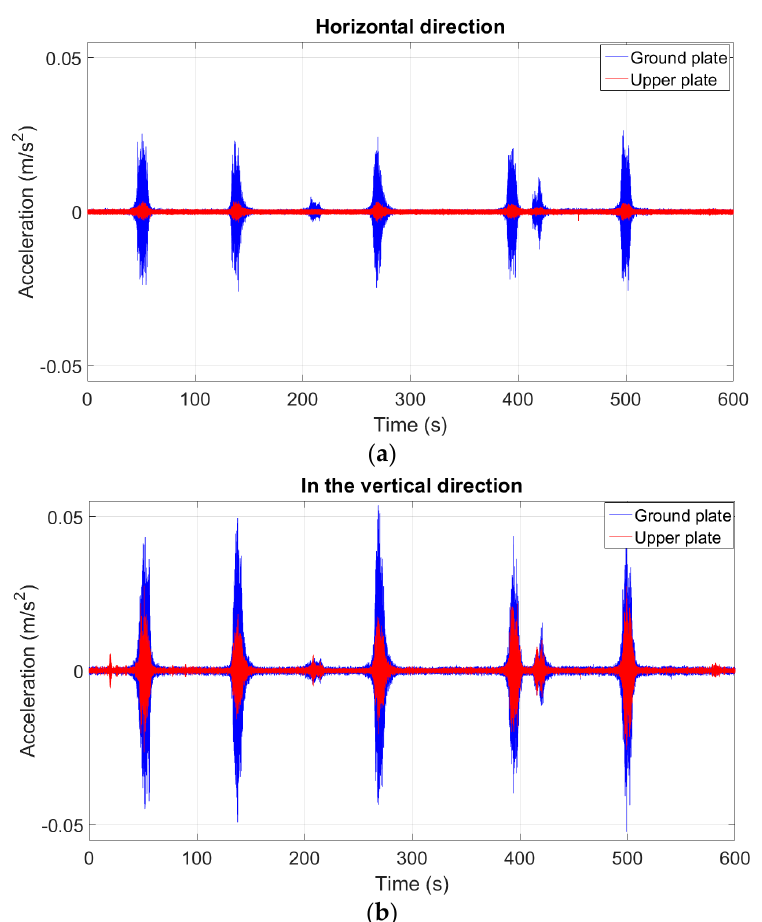
Figure 3. Measured time response for a specific time length on the seismic base and the upper plate in: ( a ) horizontal direction; ( b ) vertical direction.